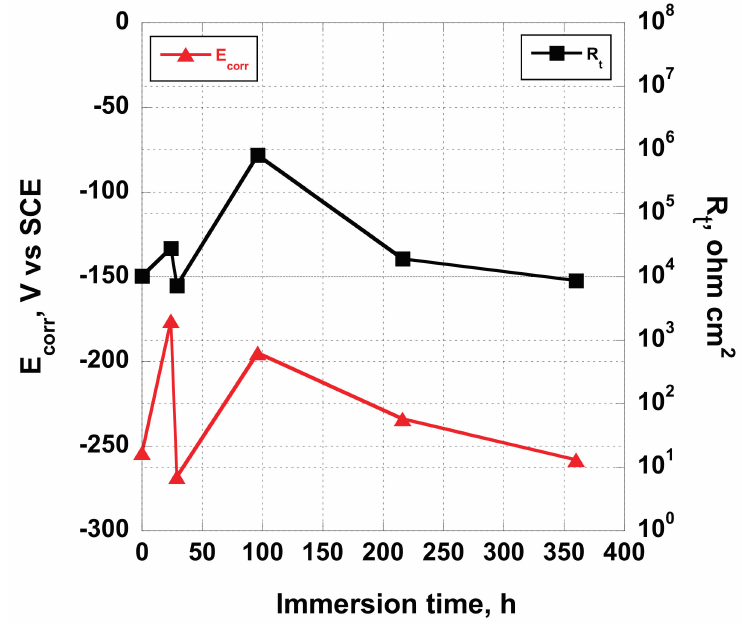
Figure 15. Variation of E corr and R t as a function of time of immersion in Hank’s solution displayed by the NT